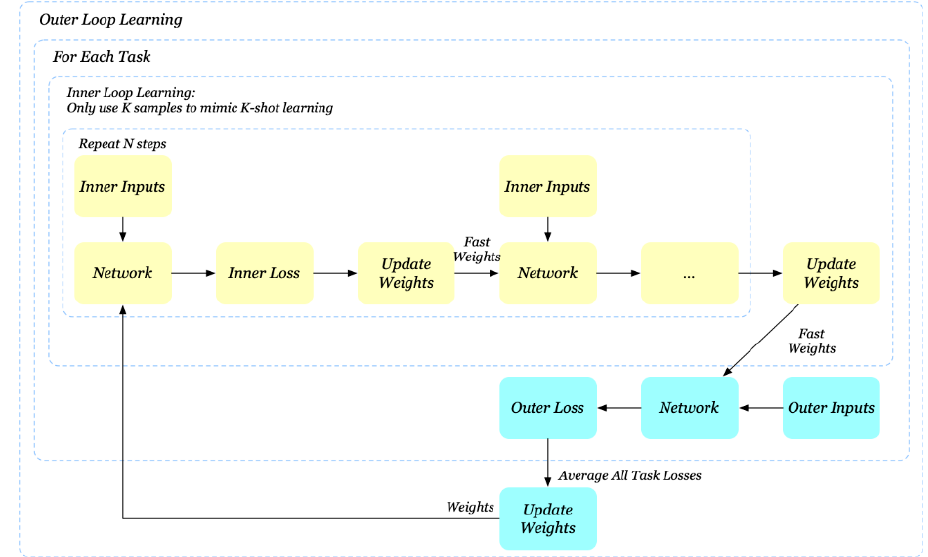
Figure 2 is a graphical illustration of the operation of the MAML algorithm.